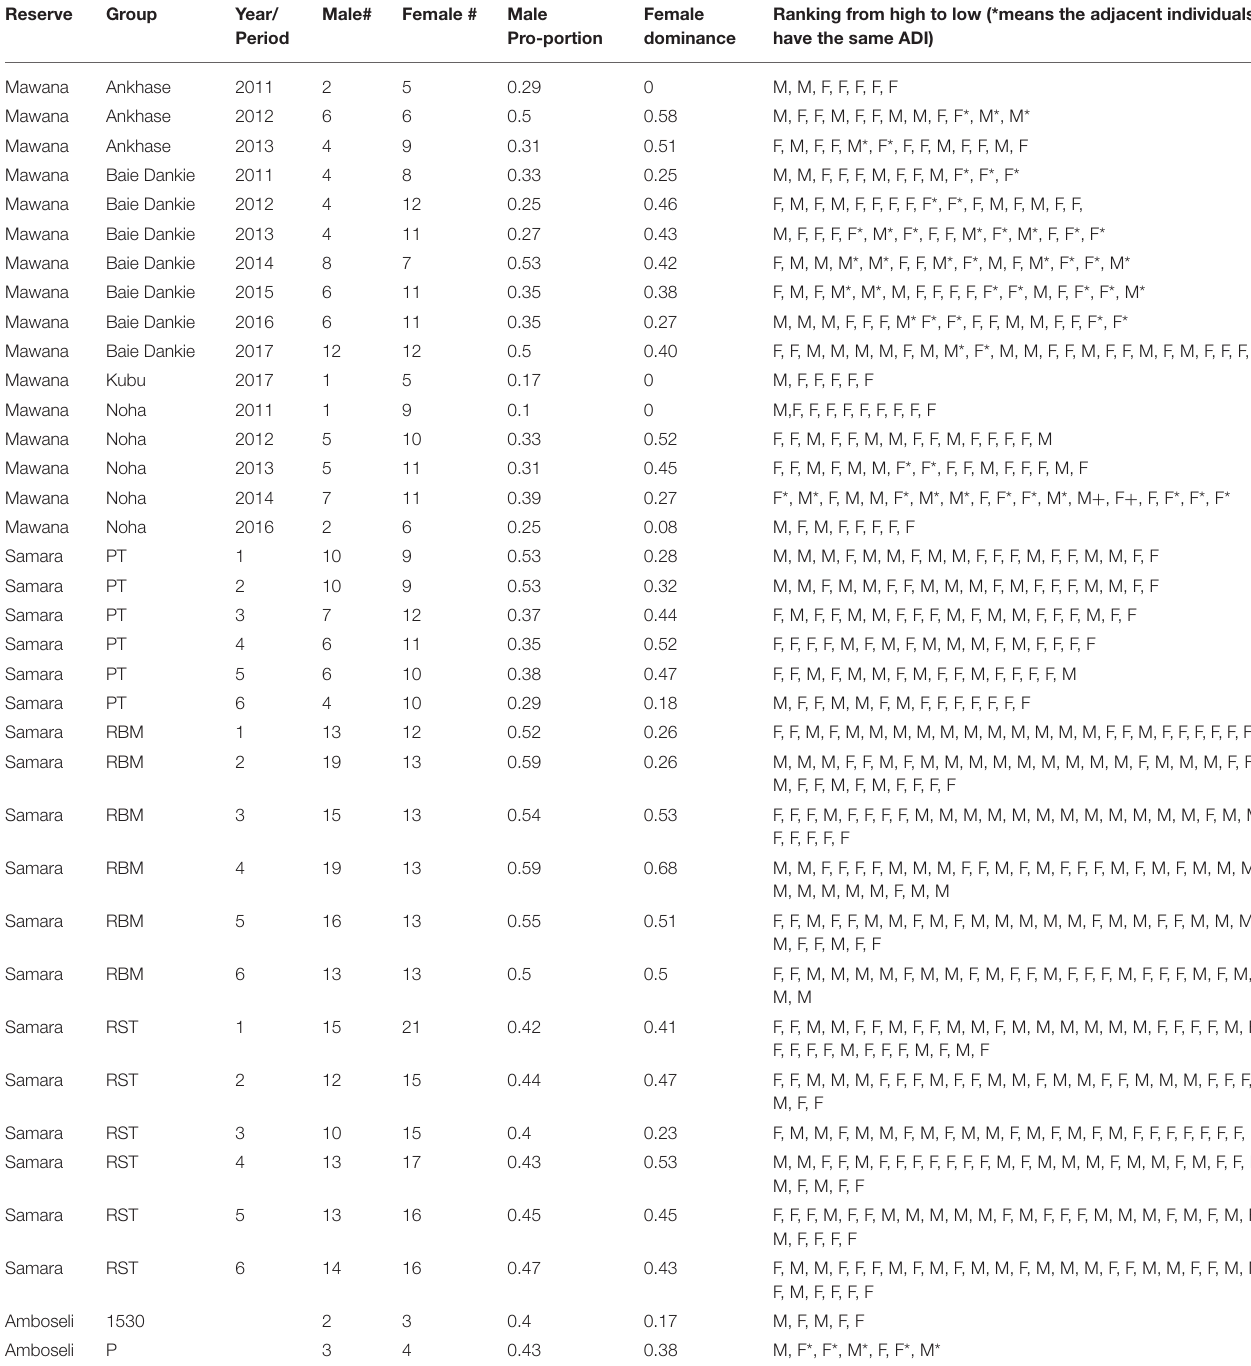
TABLE 1 | Information on the reserve, the group-name, number of adults of each sex, male proportion, female dominance, and individual rankings of both sexes per group per year. * means the adjacent individuals have the same average dominance index, ADI. Reserve